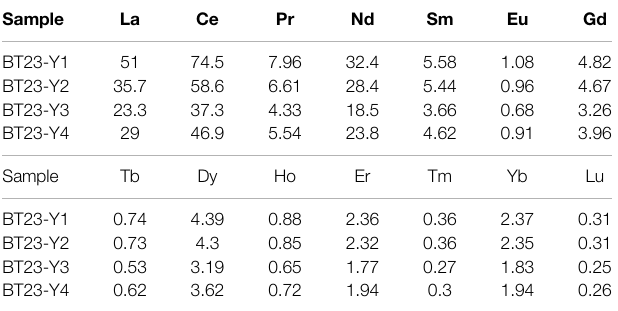
TABLE 3 | Rare Earth element composition of geothermal well cores in the study area (ug/g).